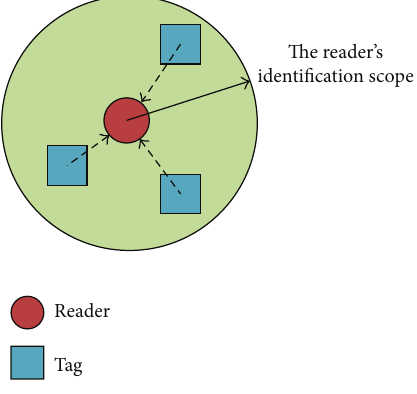
Figure 1: Tag collision